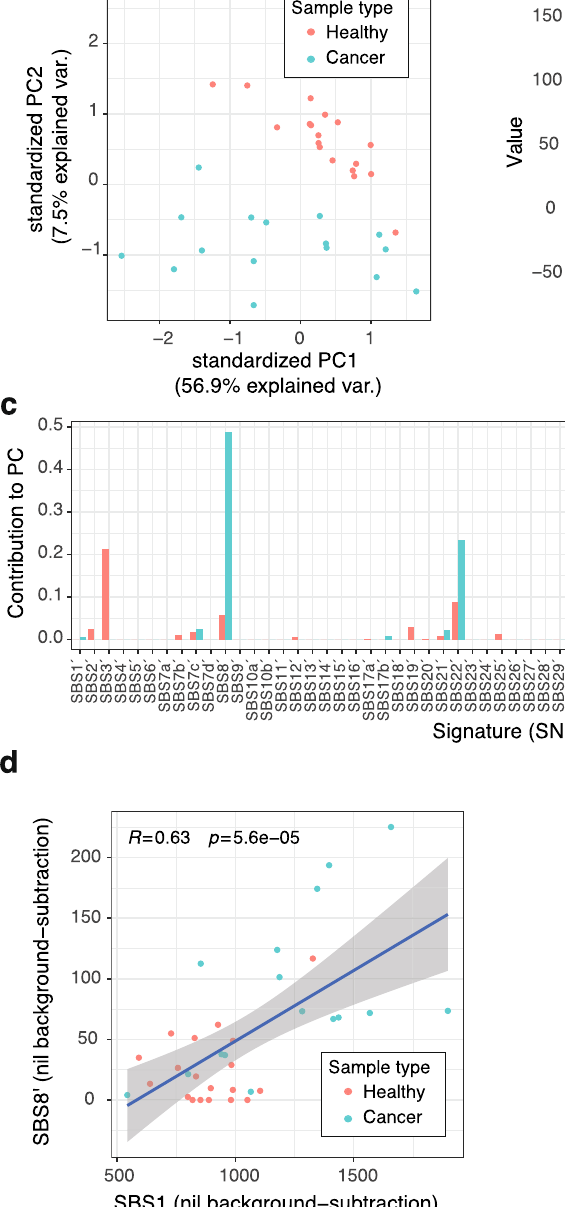
Fig. 3 | Cancer detection in stage IV colorectal cancer (CRC). a SNP-subtracted mutation pro fi les from 0.3× WGS of plasma from healthy individuals ( n =19) and patients with stage IV CRC ( n =16) were used as input for Principal Component Analysis(PCA).Healthyandcancersamplesareshowninredandblue,respectively. PC principal component. b PC1 and PC2 were correlated against ctDNA fraction determinedbyichorCNA.BothPCsshowedsigni fi cantcorrelation(PC1, p =0.0043; PC2, p =0.0076, two-sided Pearson correlation). Healthy and cancer samples are shown in red and blue, respectively. The gray shaded area indicates the 95% con- fi denceintervalofthe fi ttedlinearmodel. c ThesignaturecontributionstoPC1and PC2 were assessed by fi tting signatures to the SBS pro fi le of each PC. Signature contributions to each PC are shown as proportions. SBSn´ indicates SNP-